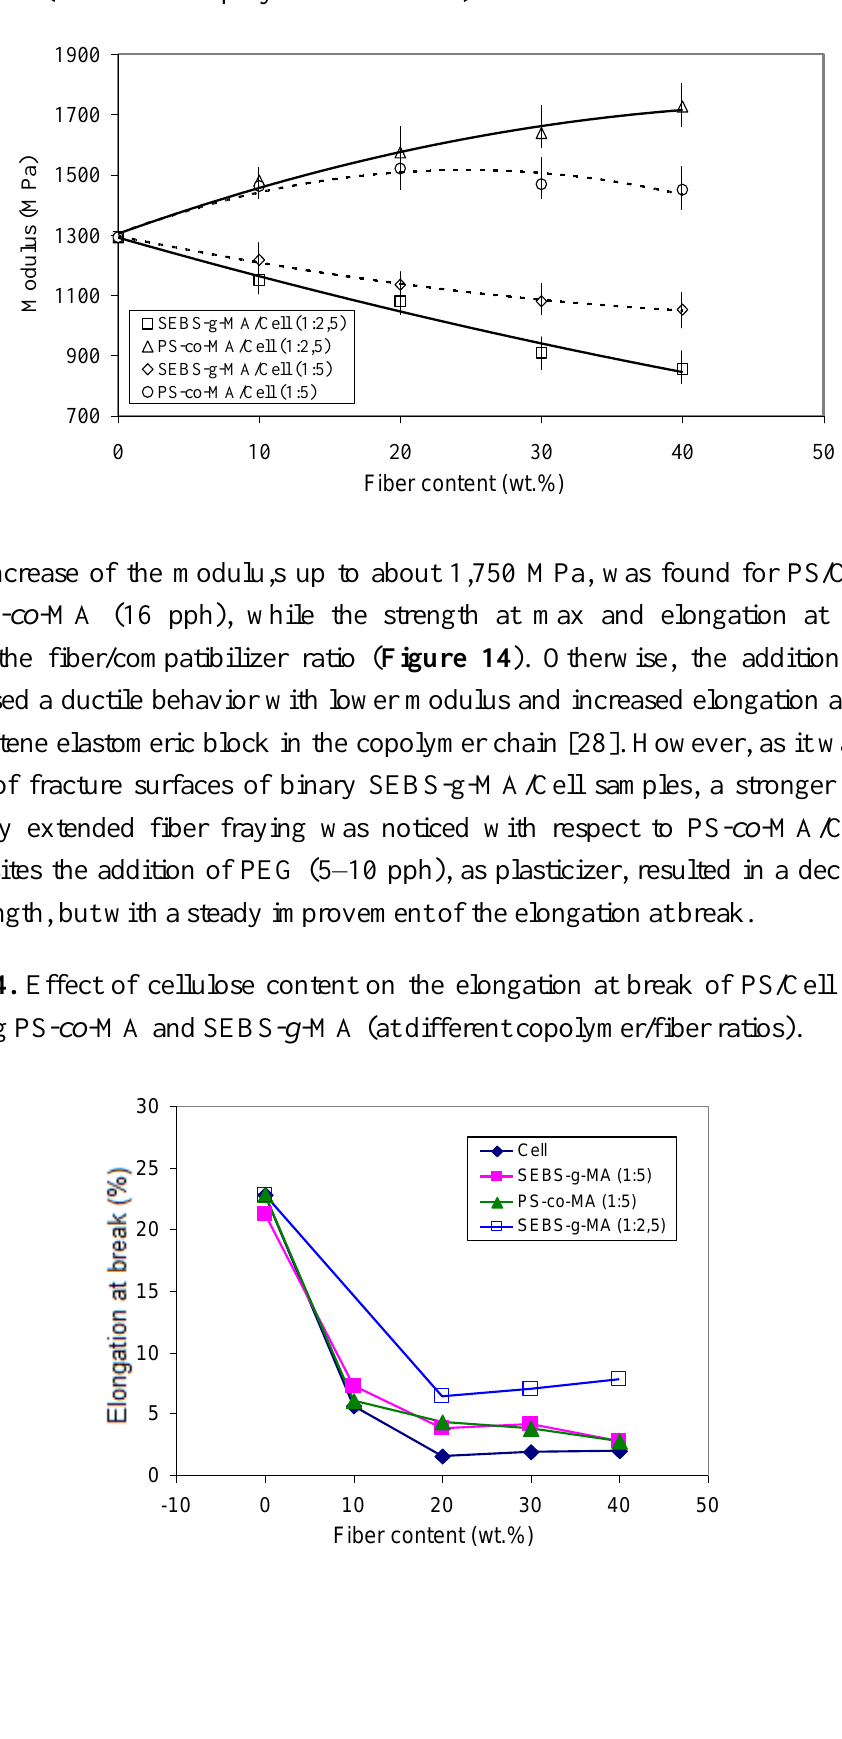
Figure 13. Elastic modulus of PS/Cell composites compatibilized with PS- co -MA and SEBS- g -MA (at different copolymer/fiber ratios) as a function of cellulose content.